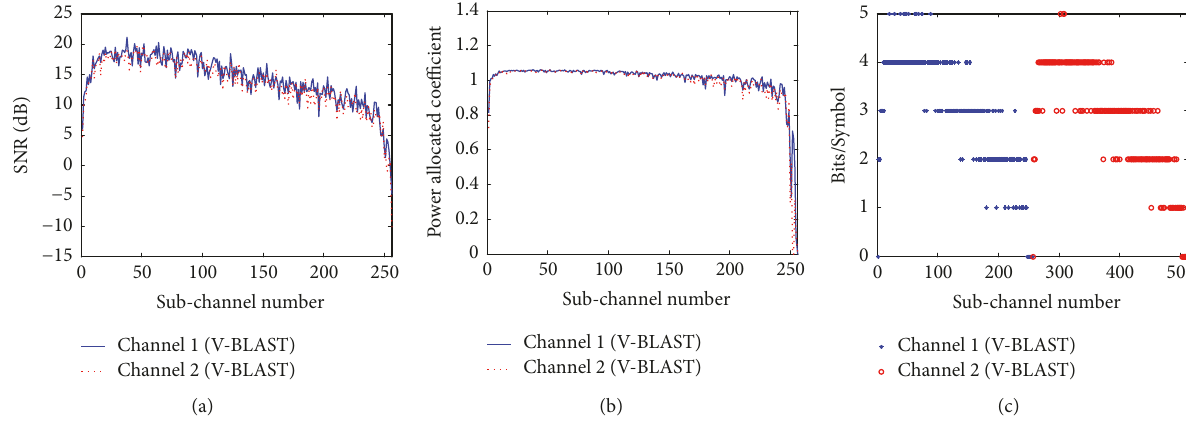
Figure 3: Power and bit allocation results for V-BLAST system ( K =2.2805, 𝐵𝐸𝑅 T